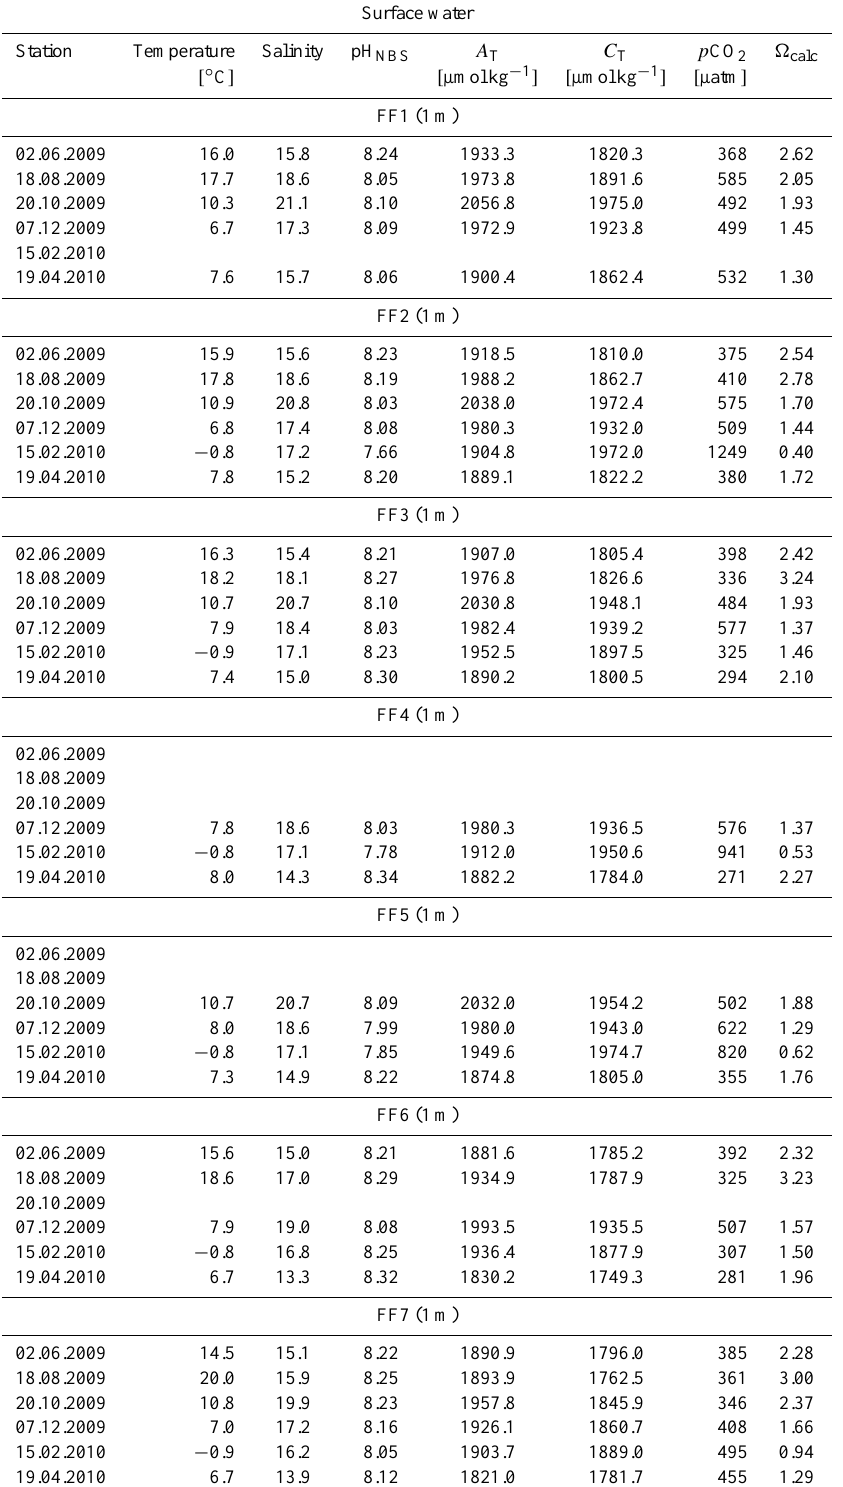
Table 2. Flensburg Fjord surface seawater chemistry speciation 2009 to 2010 at the sampling stations (FF1–FF7). Temperature and salinity were recorded using a CTD48M probe. Analyses for total alkalinity ( A T ) and dissolved inorganic carbon ( C T ) were measured by coulometric and potentiometric titration using SOMMA and VINDTA systems. pH NBS , carbon dioxide partial pressure ( p CO 2 ) and omega of calcite ( (cid:127) calc ) were calculated using the